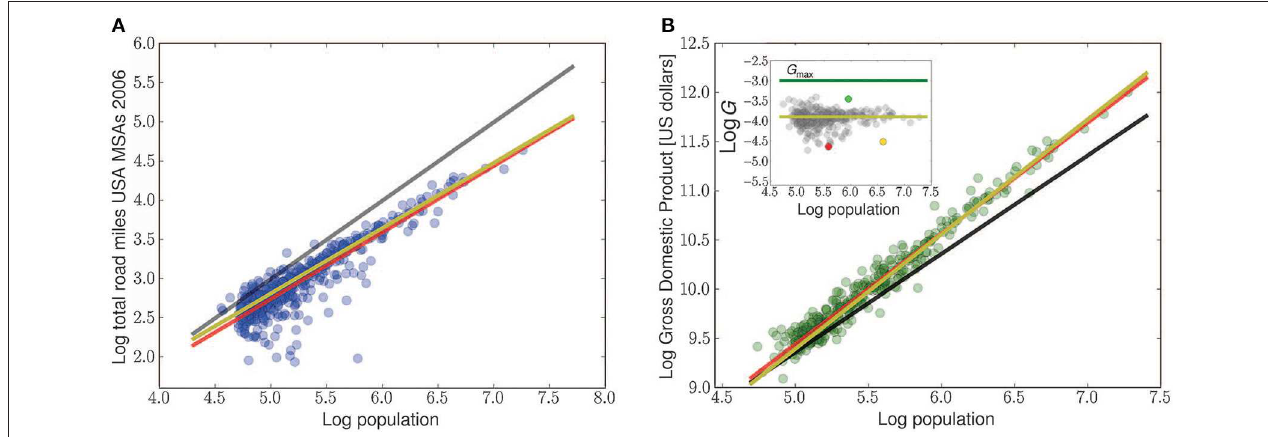
FIGURE 7 | Examples of sub-liner (A) and super-linear (B) scaling relationships in modern cities. Black line represents linear relationship (Bettencourt, 2013a, p. 1438, Figure 1, Copyright © 2013, American Association for the Advancement of Science. Reproduced with